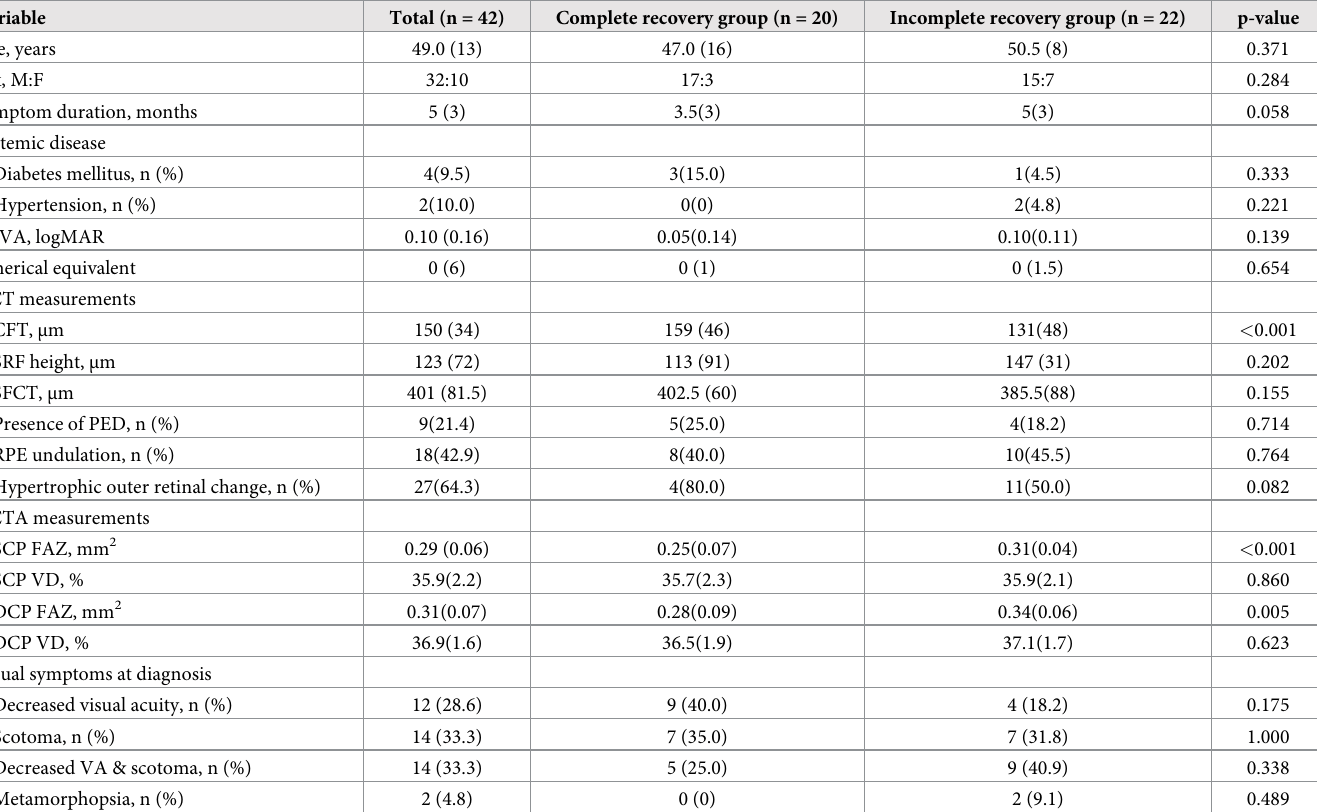
Table 1. Comparison of baseline demographics and clinical characteristics between the two